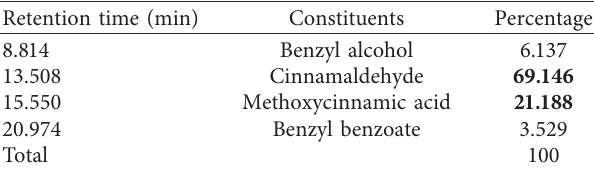
Table 2: Chemical composition of the C. cassia essential